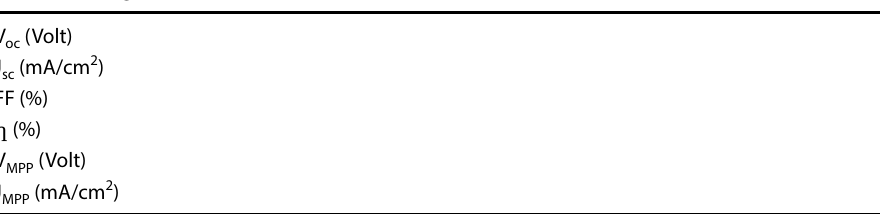
Table 2 Photovoltaic parameters of MoSe2/CIGS tandem solar